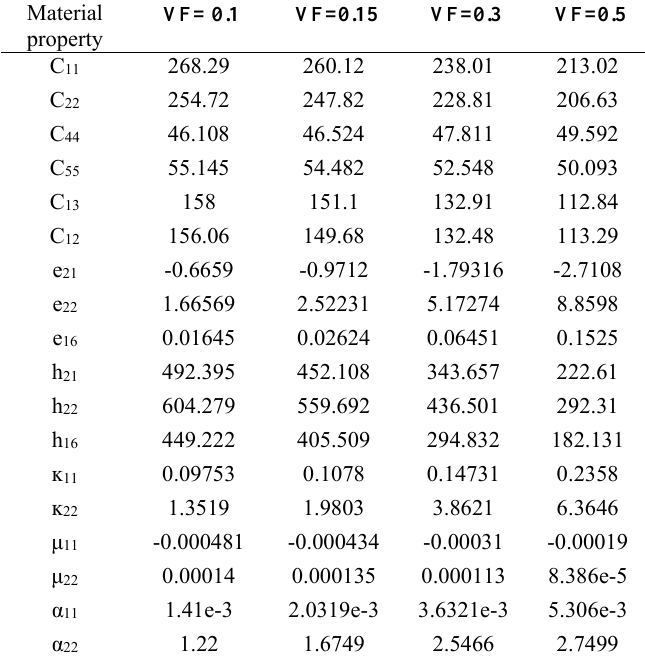
Table 2: Effective properties of fibrous Magneto-electro-elastic composites constituted of a piezo- magnetic ( CoFe 2 O 4 ) matrix reinforced by piezo-electric ( BaTiO 3 ) inclusions (C ij in GPa; κ ij in 10 -9 C 2 /Nm 2 ; μ ij in Ns 2 /C 2 , e ij in C/m 2 ; h ij in N/Am and αij in 10 -9 Ns/VC).